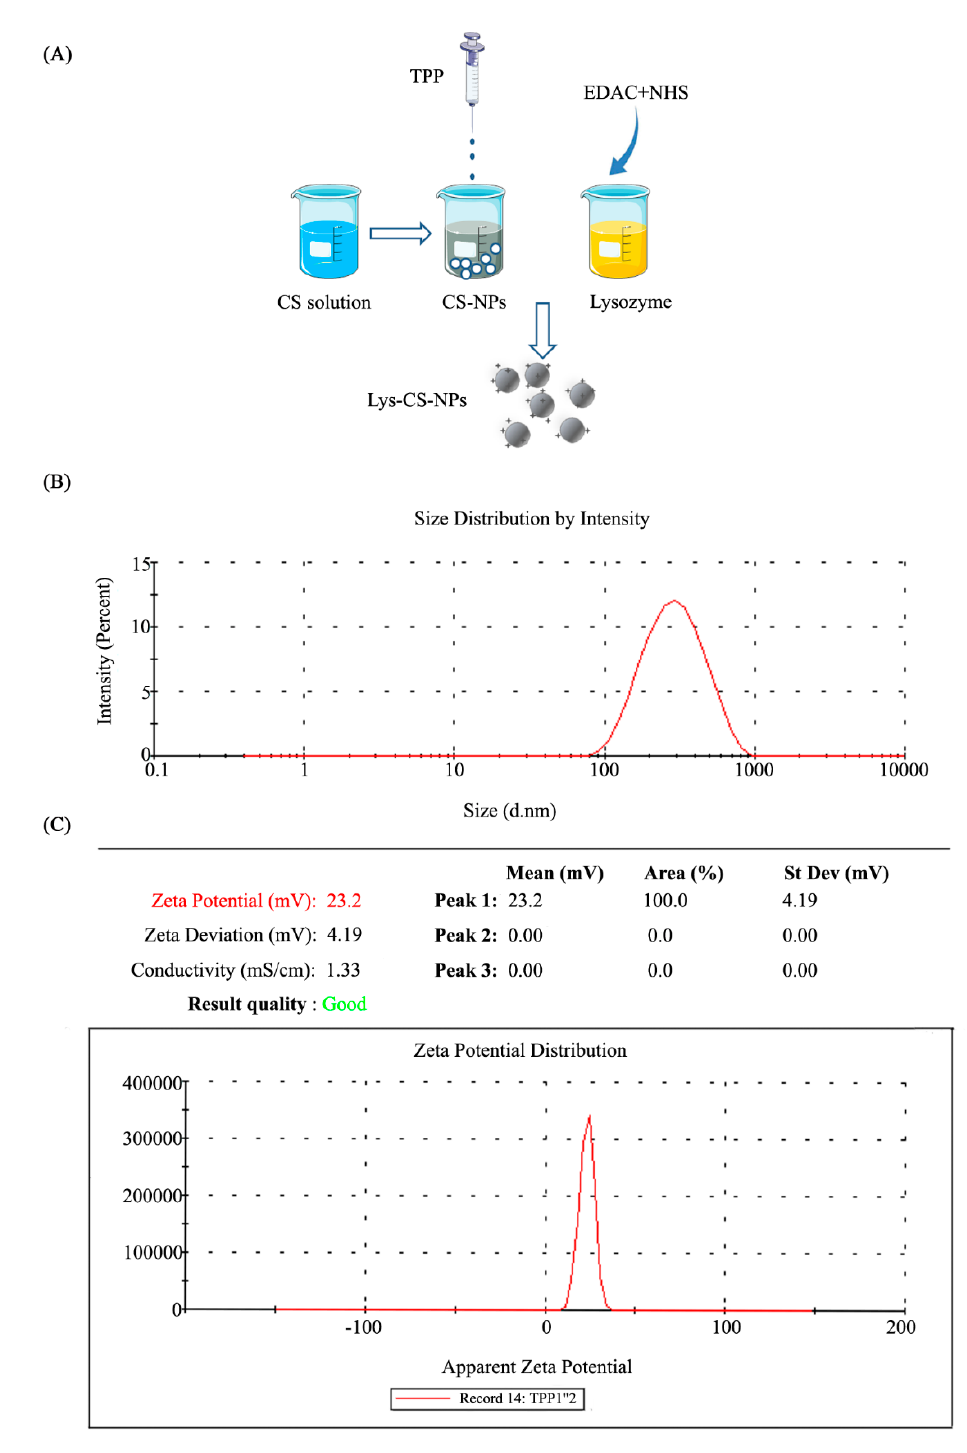
Figure 1. Characterization of nanoparticles: ( A ) schematic illustrations of the preparation process of Lys-CS-NPs; ( B ) particle size distribution of Lys-CS-NPs; and ( C ) zeta potential distribution of Lys-CS-NPs.